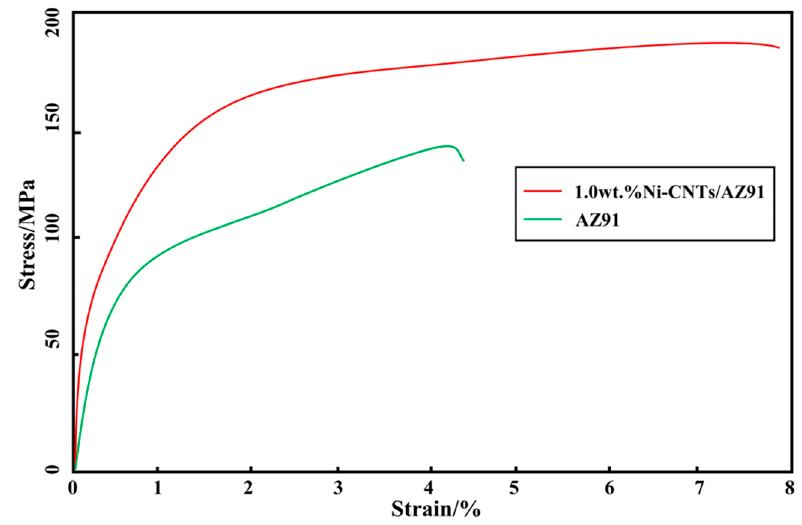
Figure 10. Tensile stress-strain curve of the two materials (AZ91 matrix material, 1.0 wt.% Ni- CNTs/AZ91 magnesium matrix composite) at room temperature.